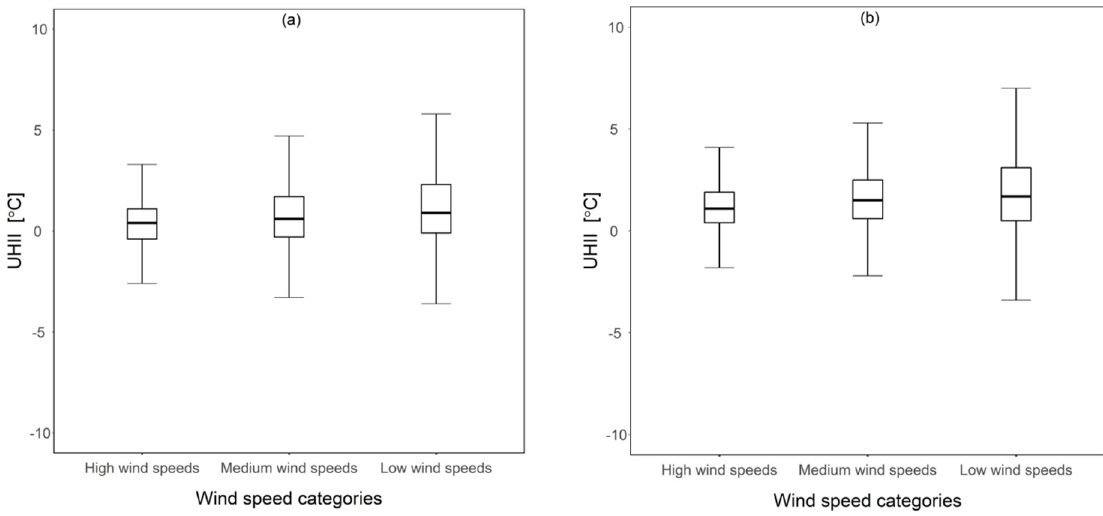
Fig 6. Mean UHII values under different wind speed conditions. (a) 2012 (b)